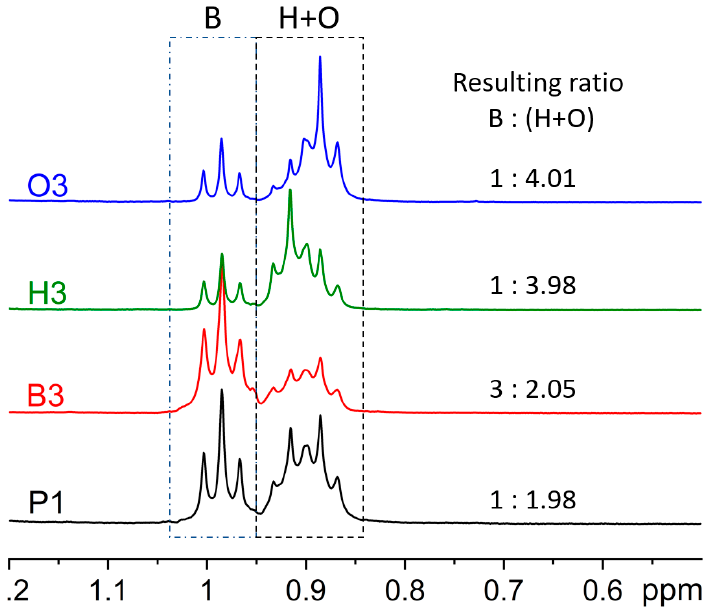
Figure 1. Selective 1 H-NMR (CDCl 3 , 400 MHz) spectra of four block copolymers (P1, B3, H3 and O3). Therefore, the completeness of polymerization, that is, the degree of monomer con- version, was investigated using quantitative NMR (qNMR) analysis based on ‘internal standard’ referencing, as reported previously [22,23]. To apply this method, polymerization was performed with naphthalene as the internal standard. For example, three triblock copolymers, B3, H3, and O3, were investigated using qNMR. The peaks at 6.82 ppm